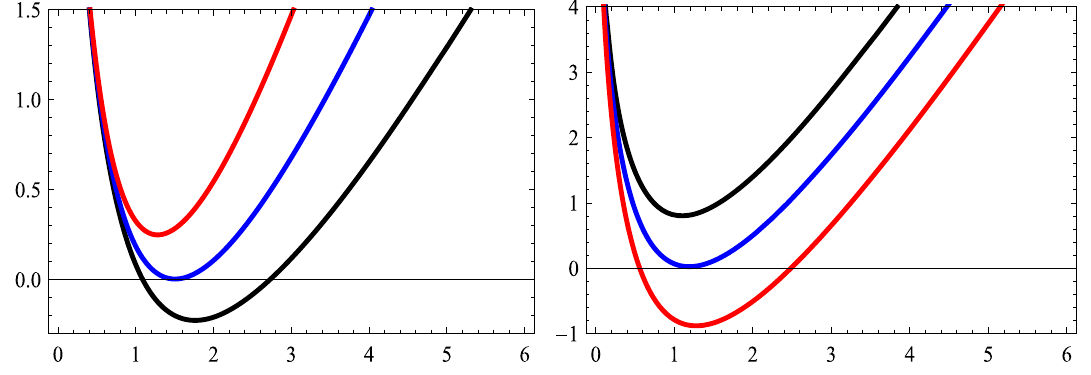
, b = 1 , (cid:20) = 1 , r = 1 , m = 8 , (cid:18) = − 1 , q = 1. Left: α = 2 and a = 1 . 06(black) , 1 . 13(blue) , 1 . 25(red). Fig. 2 W ( r ) versus r for ν = − 2 0 3 Right: a = 1 . 4 and α = 1 . 98(black) , 2 . 023(blue) , 2 .